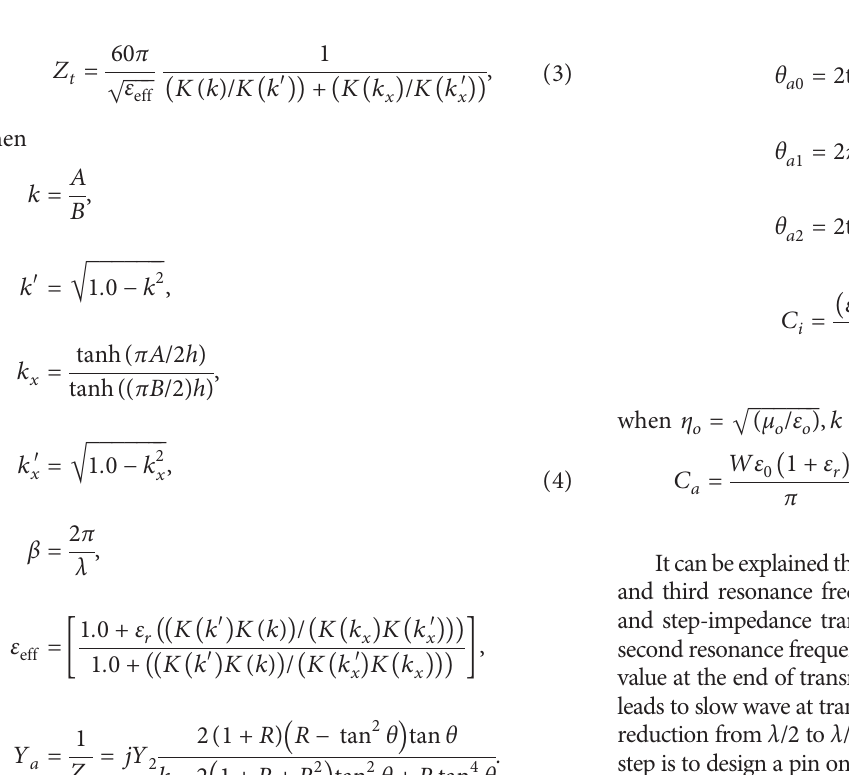
Figure 2: The equivalence circuit of ICPW-EBG unit